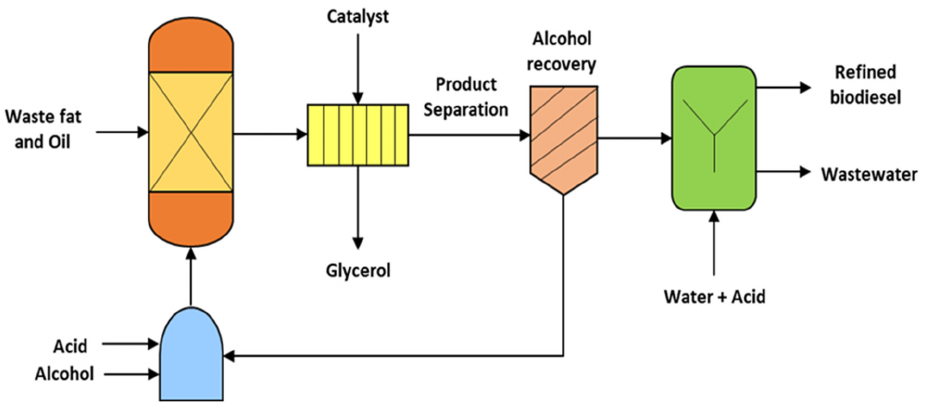
Figure 5. Typical process representation of transesterification of waste fats and oil.